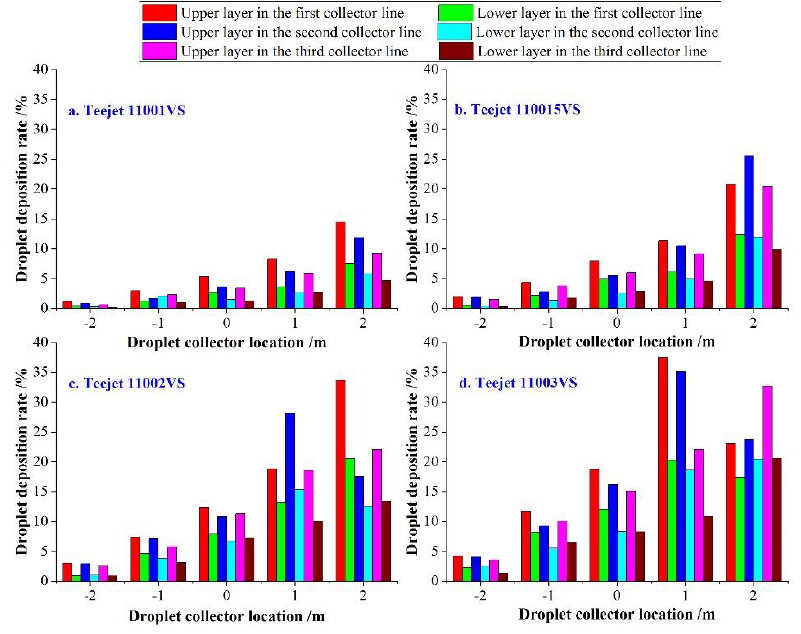
Figure 5. Droplet deposition distribution in target area.